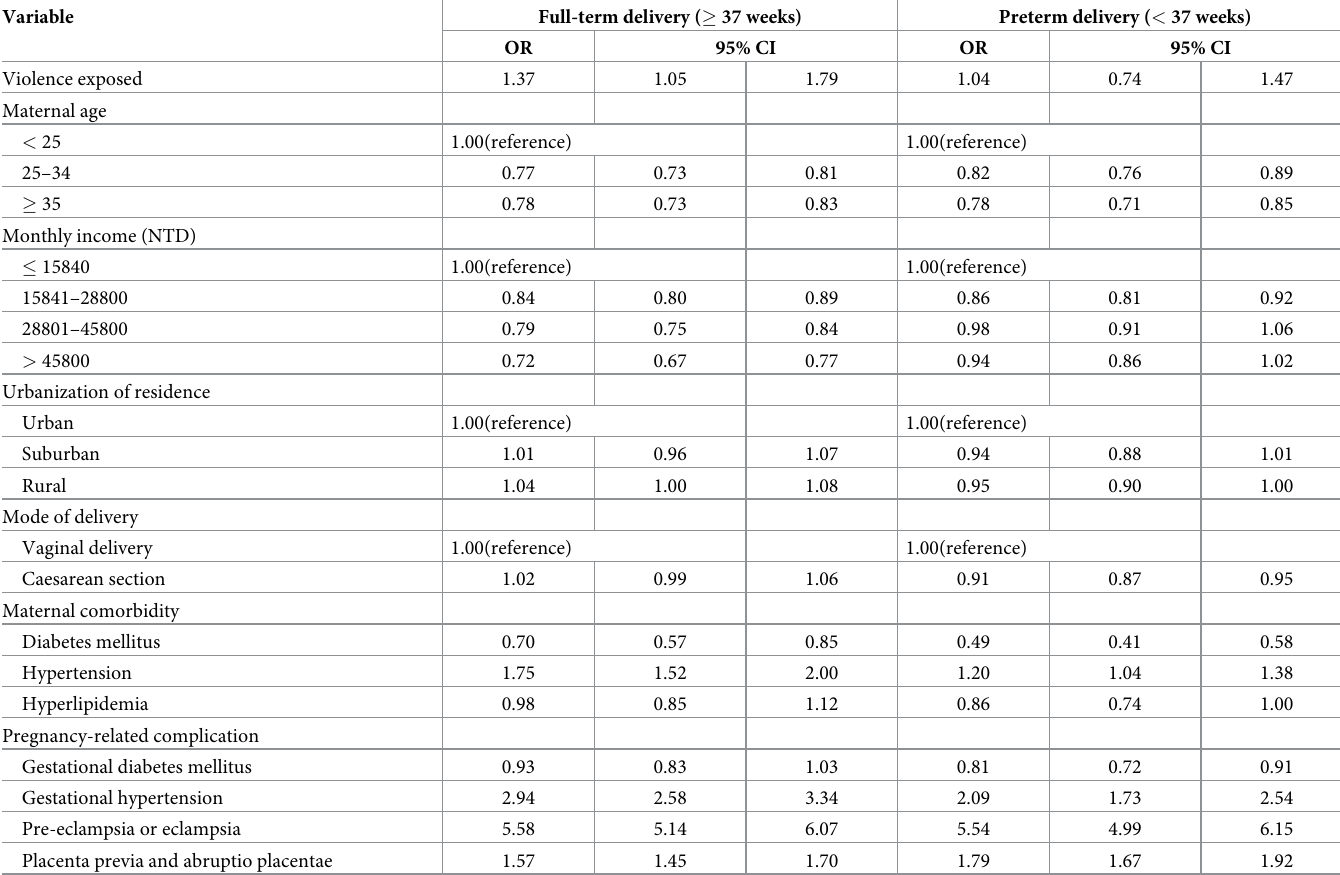
Table 2. Multivariable analysis of factors associated with low birthweight ( < 2500 g), stratified by full-term or preterm